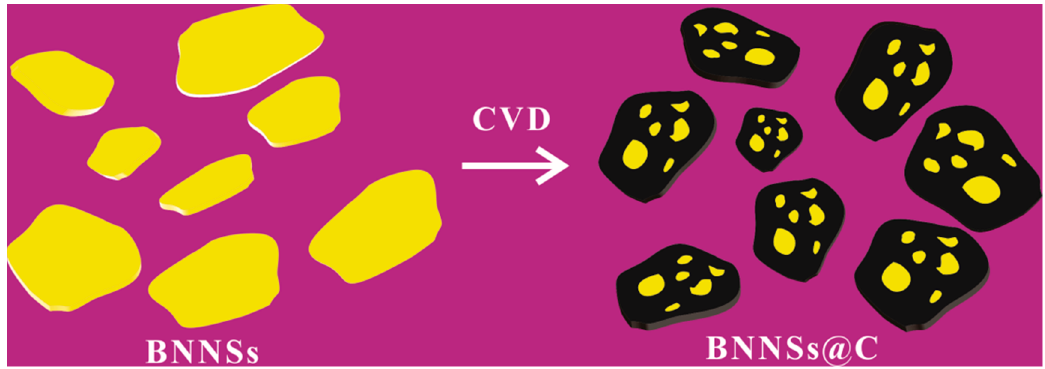
Figure 1. Schematic illustration of the synthesis procedure of BNNSs@C hybrids.